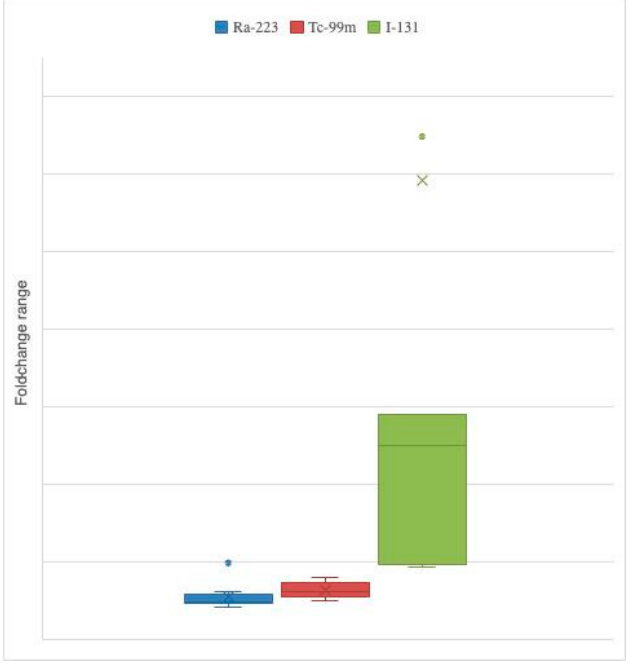
Figure 2. Fold change range found with each radiopharmaceutical.